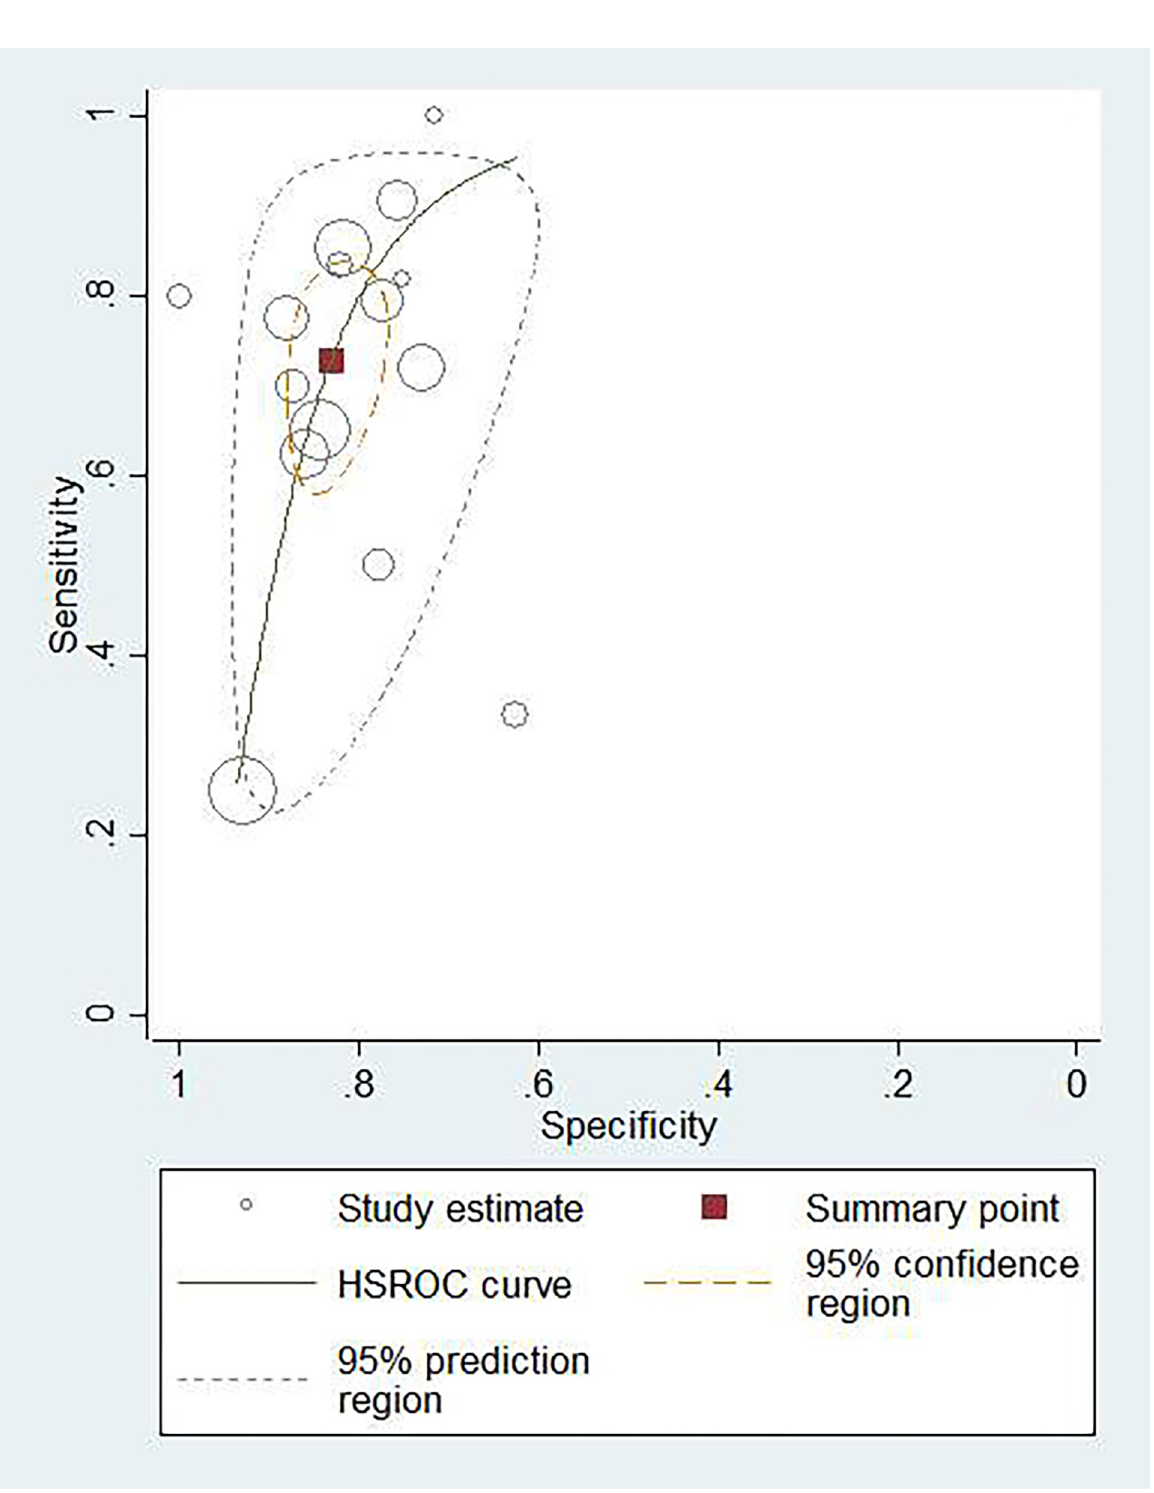
Fig 3. Hierarchical summary receiver operating characteristic (HSROC) plot to summarize diagnostic accuracy for blood IGRA in diagnosing tuberculous meningitis (blue curve). Summary estimate of diagnostic accuracy is indicated by the red square.